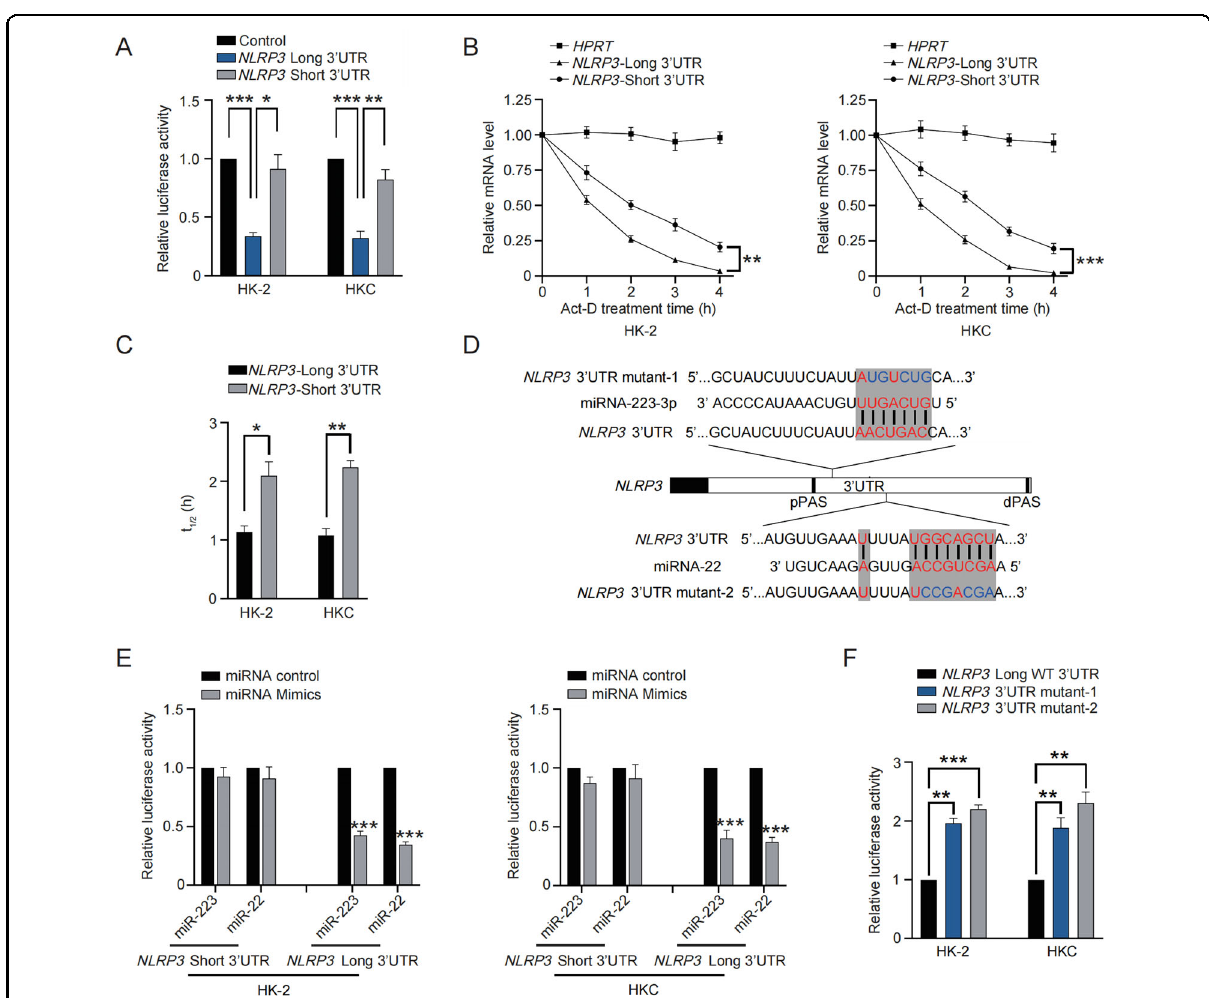
Fig. 3 3 ′ UTR shortening of NLRP3 bene fi ts mRNA stability and leads to enhanced protein expression of NLRP3. A Luciferase reporter assay was performed in HK2 and HKC cells to examine luciferase activity produced by reporters carrying short 3 ′ UTR or long 3 ′ UTR of NLRP3 respectively. B Isoform-speci fi c qRT-PCR was performed to determine long-3 ′ UTR and short-3 ′ UTR NLRP3 mRNA half-life in HK2 and HKC cells treated with Act-D. Total RNA was normalized with HPRT . C The bar graph showing the half-life in hours calculated for long-3 ′ UTR NLRP3 and short-3 ′ UTR NLRP3 . D Schematic diagram showing the binding sites of miRNAs in NLRP3 3 ′ UTR and the mutant NLRP3 used in F . E Luciferase reporter assay was performed to examine luciferase activity produced by reporters carrying short 3 ′ UTR or long 3 ′ UTR of NLRP3 respectively in HK2 and HKC cells co- transfected with mimics of miR-223 or miR-22. F Luciferase reporter assay was performed to examine luciferase activity produced by reporters carrying long 3 ′ UTR of NLRP3 or mutants of long 3 ′ UTR of NLRP3 respectively. * P < 0.05; ** P < 0.01; *** P < 0.001; All data represent the mean ± SEM obtained from three independent experiments. Student ’ s t